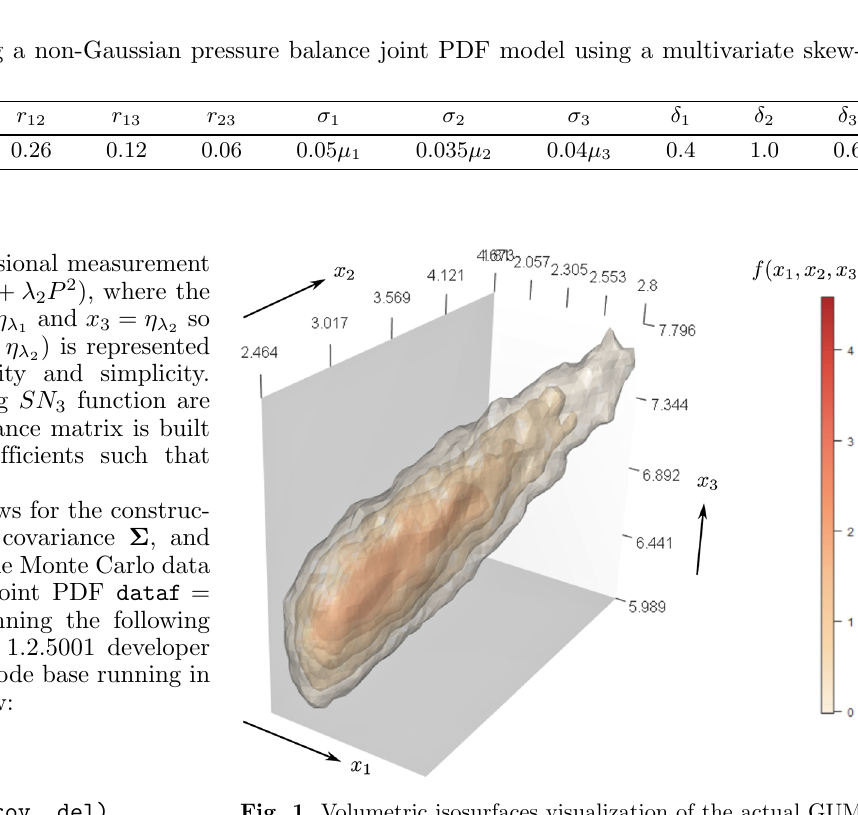
Fig. 1. Volumetric isosurfaces visualization of the actual GUM supplement 2 non-Gaussian joint PDF obtained from synthetic sampled Monte Carlo simulation data-points generated from a three-variable Azzalini multivariate skew-normal joint